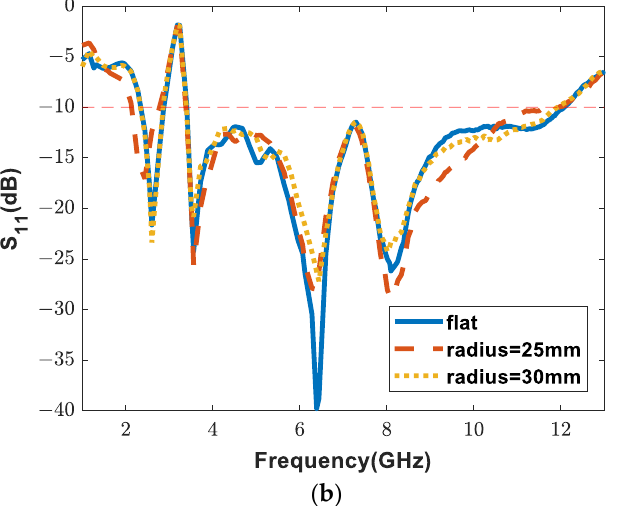
Figure 17. S-parameter when the antenna is bent. ( a ) When bent horizontally, S-parameter according to the radius of the bend; ( b ) when bent vertically, S-parameter according to the radius of the bend.